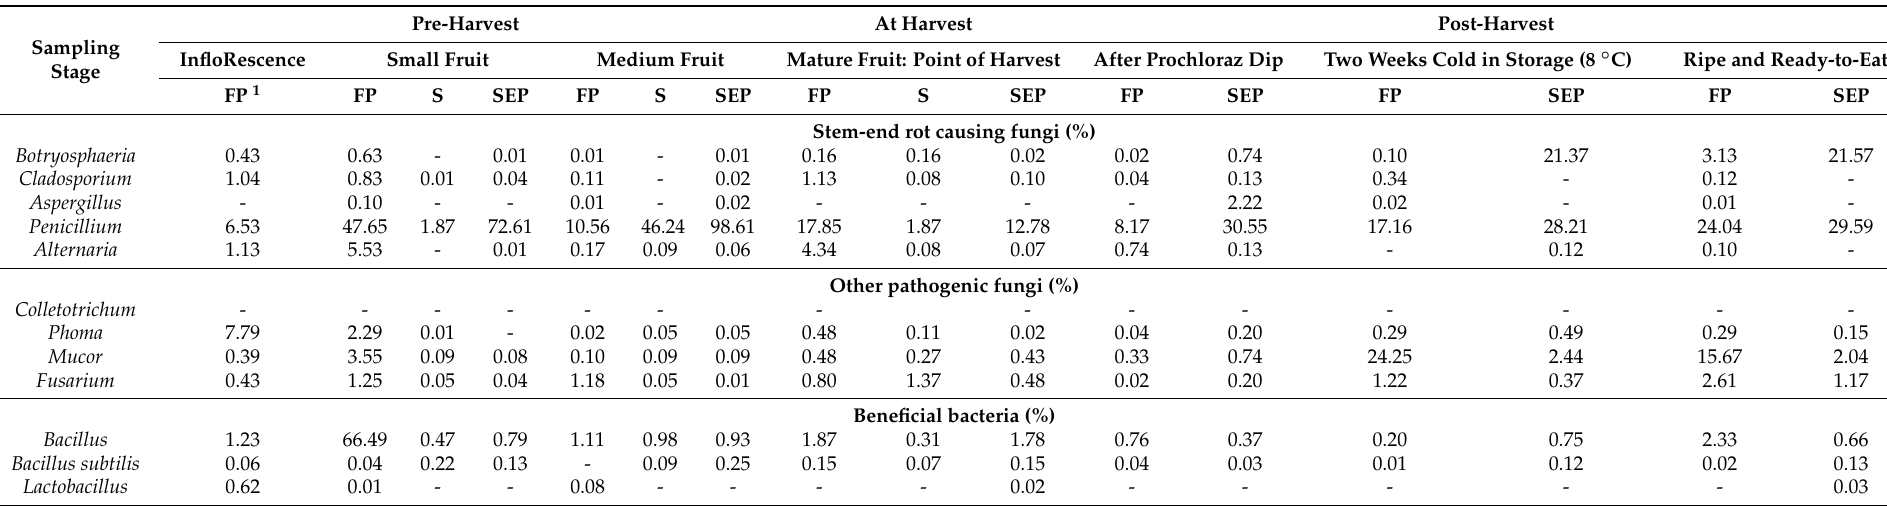
Table 5. Genera of pathogenic and beneficial microorganisms detected in cv. Tommy Atkins mangoes sequence